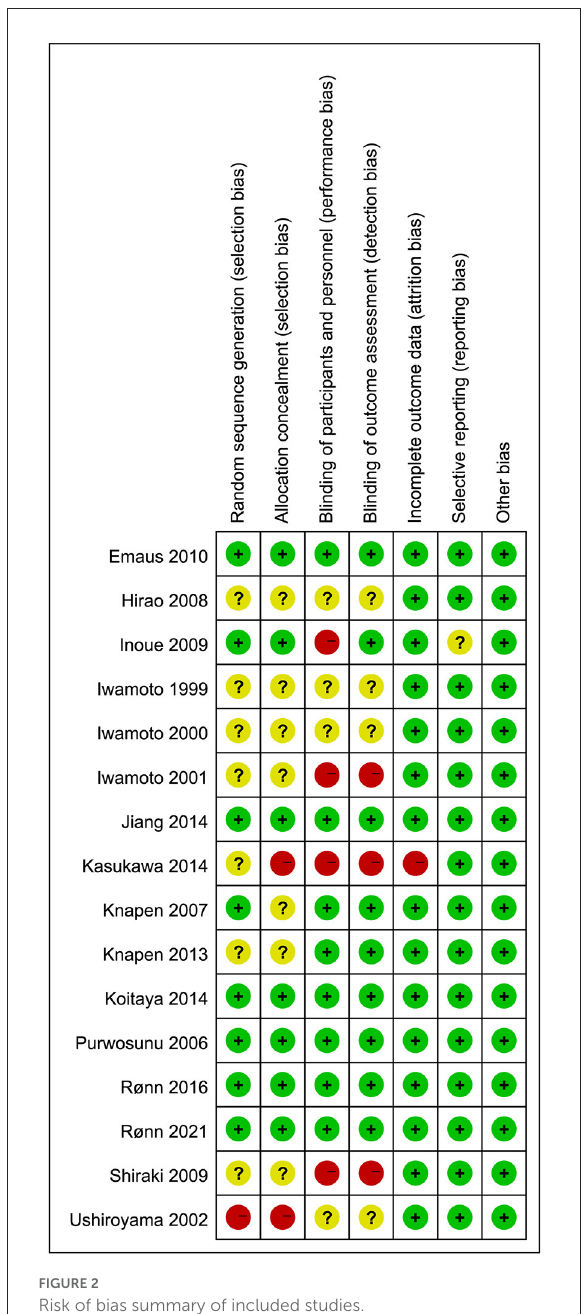
FIGURE2 Risk of bias summary of included studies.